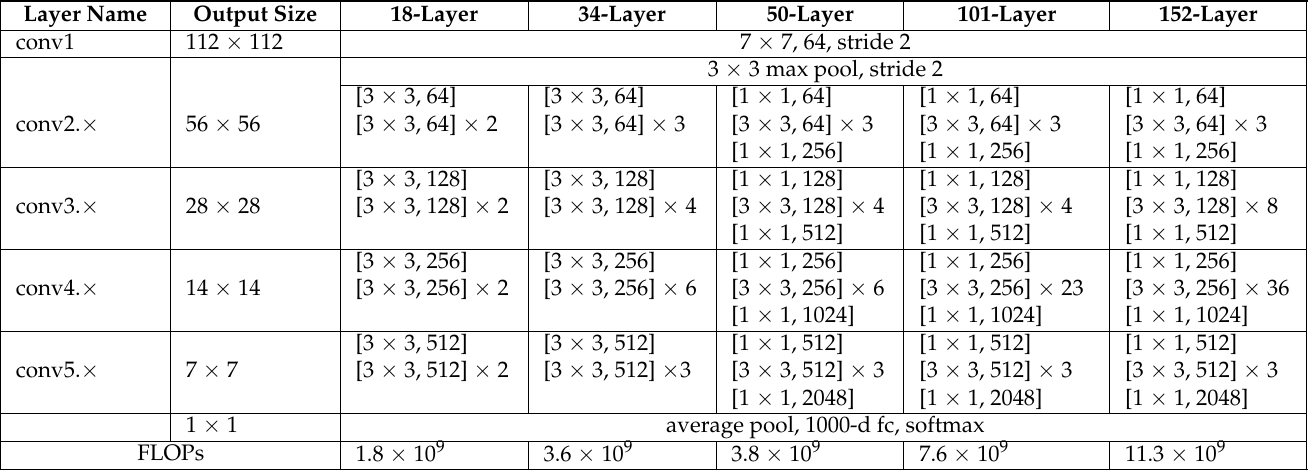
Table 3. ResNet architecture recreation, based on the original image found in